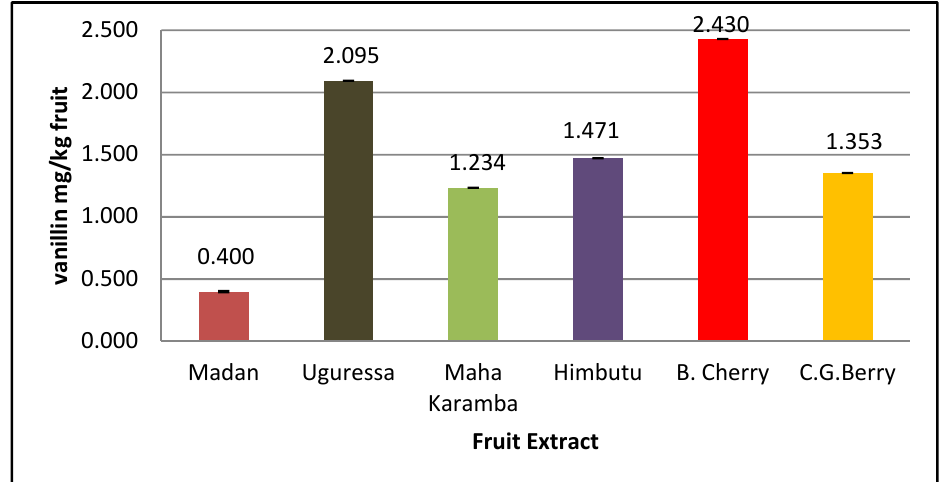
Figure 2. Vanillin content of six underutilized fruit extracts.